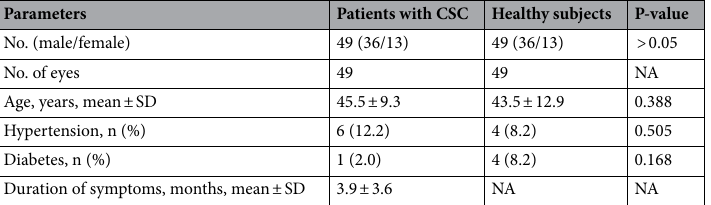
CSC eyes Fellow eyes Healthy control eyes P-value 1 P-value 2 P-value 3 Best corrected visual acuity in logMAR, IQR, range 0.1 (0,0.3) 0